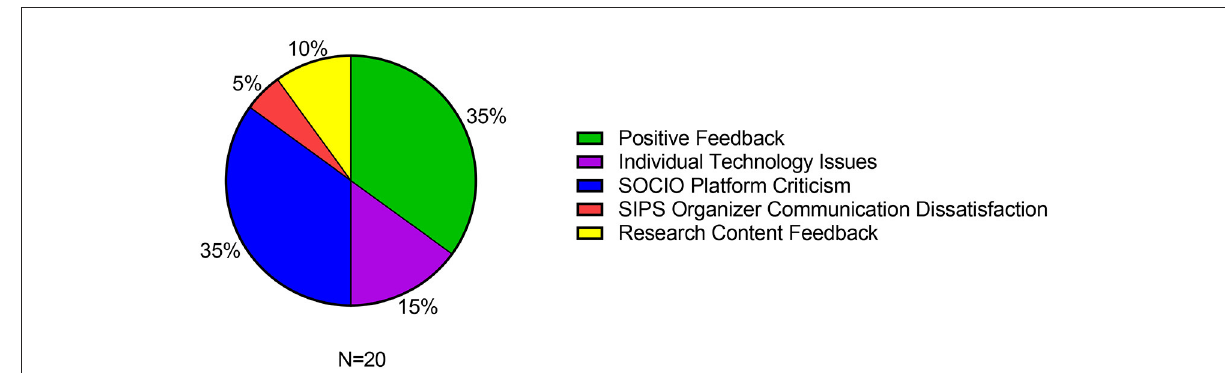
FIGURE6 Overall feedback on SIPS 2021 conference based on post-conference